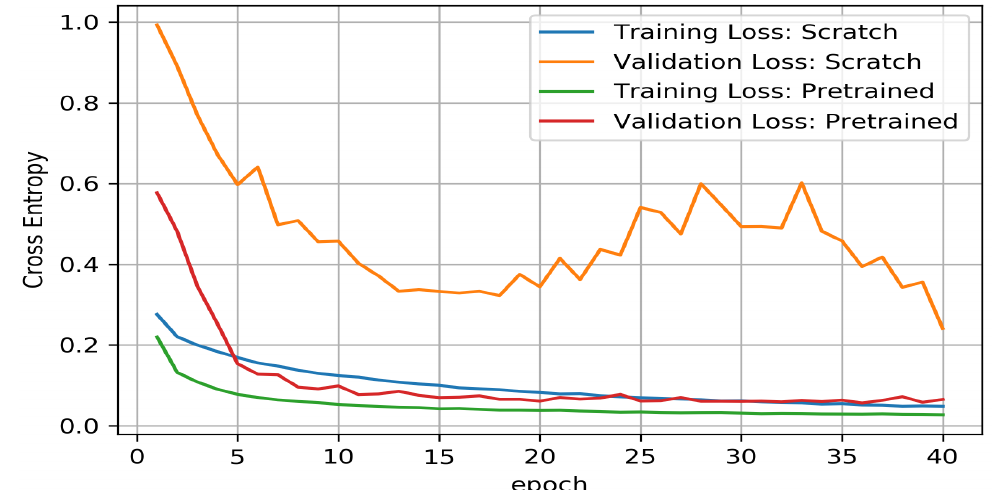
Figure 5. Comparison between model from scratch and model initialized with pretrained classifica- tion